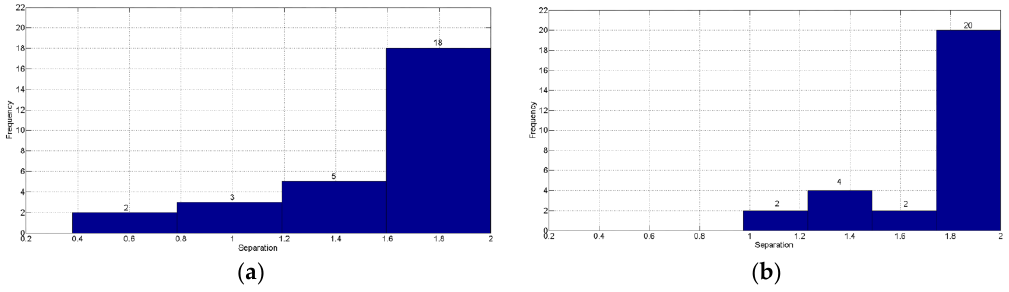
Figure 6. Distribution plots of separability values calculated based on ( a ) whole kernel data and ( b ) germ region data.